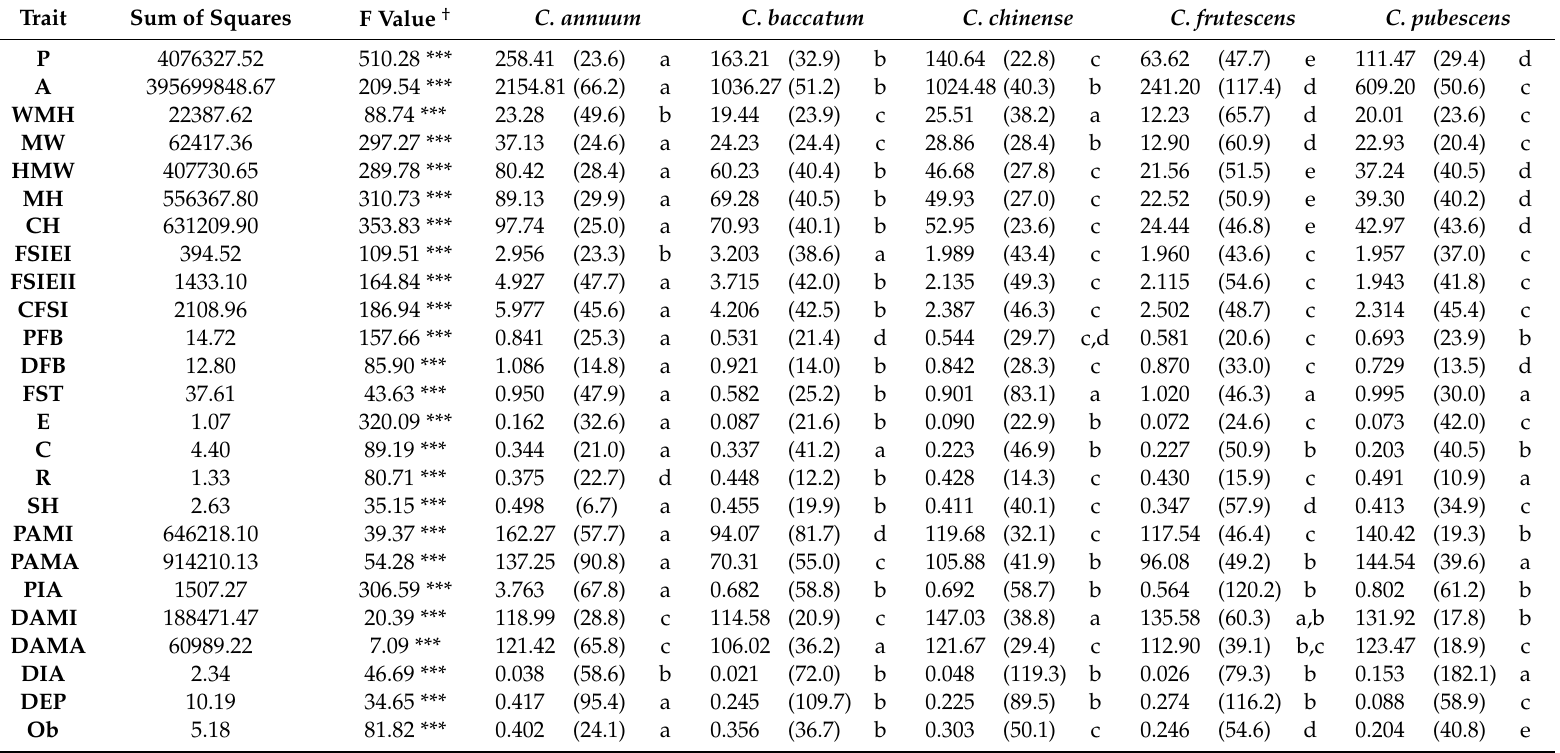
Table 3. Analysis of variance for TA descriptors among the five Capsicum species (left). Mean (Coe ffi cient Variation %) for each group (right). Di ff erent letters within the same row indicate significant di ff erences at p < 0.05. P = Perimeter, A = Area, WMH = Width mid-height, MW = Maximum width, HMW = Height mid-width, MH = Maximum height, CH = Curved height, FSIEI = Fruit shape index external I, FSIEII = Fruit shape index external II, CFSI = Curved fruit shape index, PFB = Proximal fruit blockiness, DFB = Distal fruit blockiness, FST = Fruit shape triangle, E = Ellipsoid, C = Circular, R = Rectangular, SH = Shoulder height, PAMI = Proximal angle micro, PAMA = Proximal angle macro, PIA = Proximal indentation area, DAMI = Distal angle micro, DAMA = Distal angle macro, DIA = Distal indentation area, DEP = Distal end protrusion, Ob = Obovoid, Ov = Ovoid, VAs = V.Asymmetry, HAob = H.Asymmetry.Ob, HAov = H.Asymmetry.Ov, WWP = Width widest position, EC = Eccentricity, PEC = Proximal eccentricity, DEC = Distal eccentricity, FSII = Fruit shape index internal, ECAI = Eccentricity area index, LD = Lobedness degree, TPA = Tomato pericarp area, TPAR = Tomato pericarp area ratio, TPT = Tomato pericarp thickness, TPTR = Tomato oericarp tickness ratio, PPB = Pepper pericarp